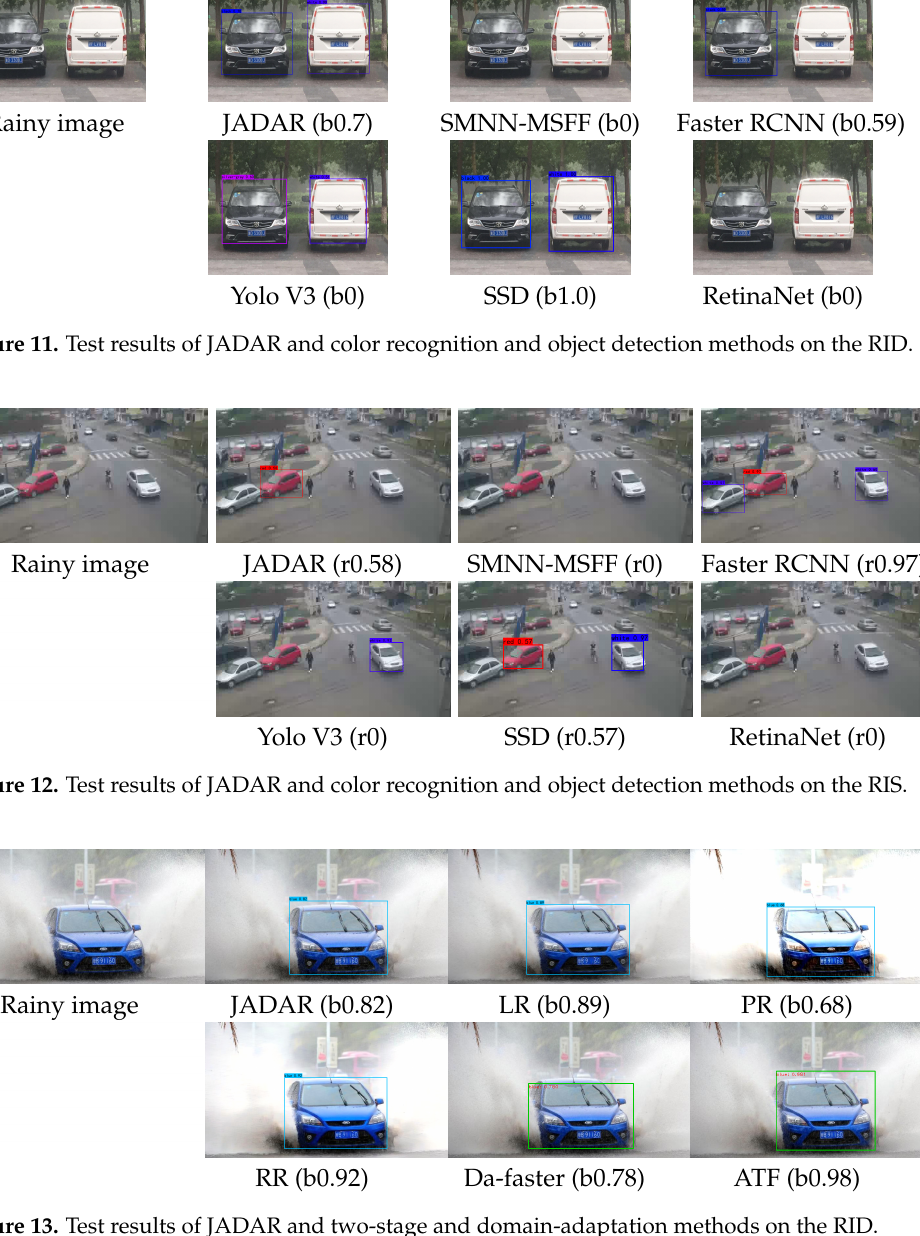
Figure 13. Test results of JADAR and two-stage and domain-adaptation methods on the RID.